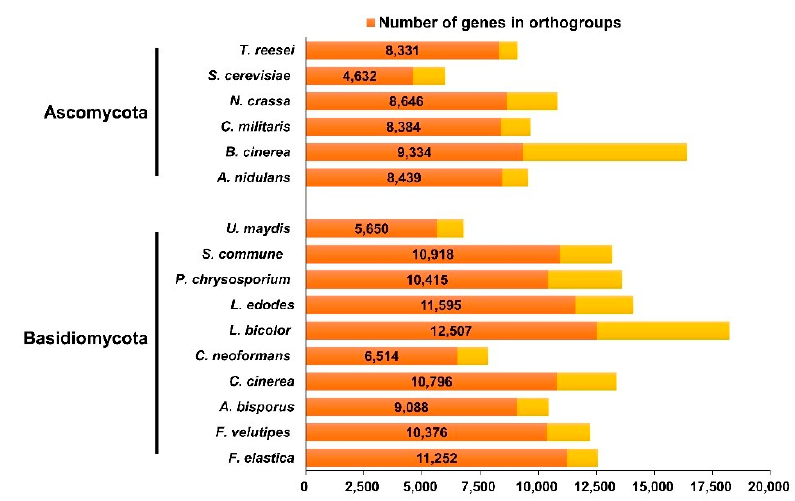
Figure 1. Number of genes and orthologs in F. elastica and other fungal species.